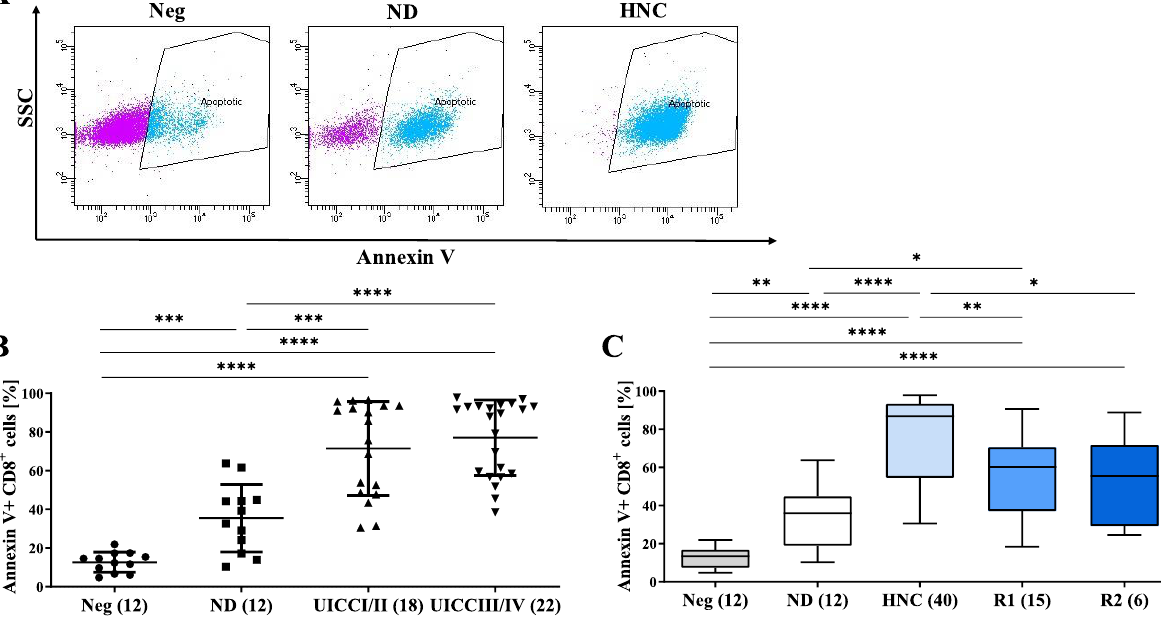
Figure 5. The induction of apoptosis of CD8 + Jurkat cells depends on HNC disease activity. ( A ) Representative pictures of the gating strategy of sEV-mediated apoptosis in CD8 + Jurkat cells. ( B ) sEVs from HNC patients induce significantly more apoptosis in CD8 + Jurkat cells than sEVs from ND. ( C ) The apoptosis induction of CD8 + cells decrease during follow-up and almost equalizes NDs at six months follow-up. Neg: Negative control (PBS/no sEVs). A p -value below 0.05 was considered as significant (* p < 0.05; ** p < 0.01; *** p < 0.001; **** p < 0.0001).